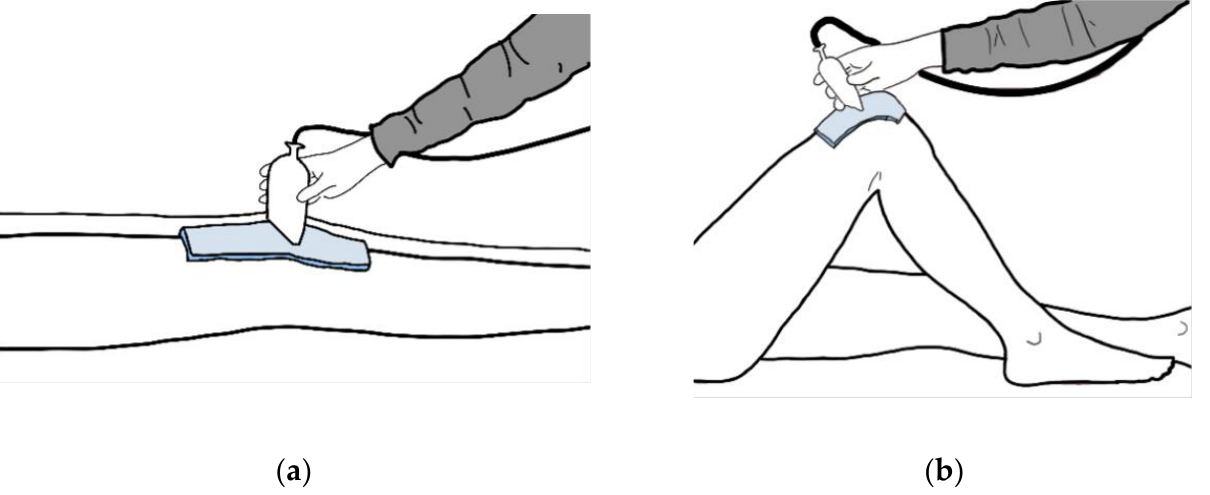
Figure 1. The ultrasound-based protocol for the assessment of ( a ) patella diameter; ( b ) sulcus angle.